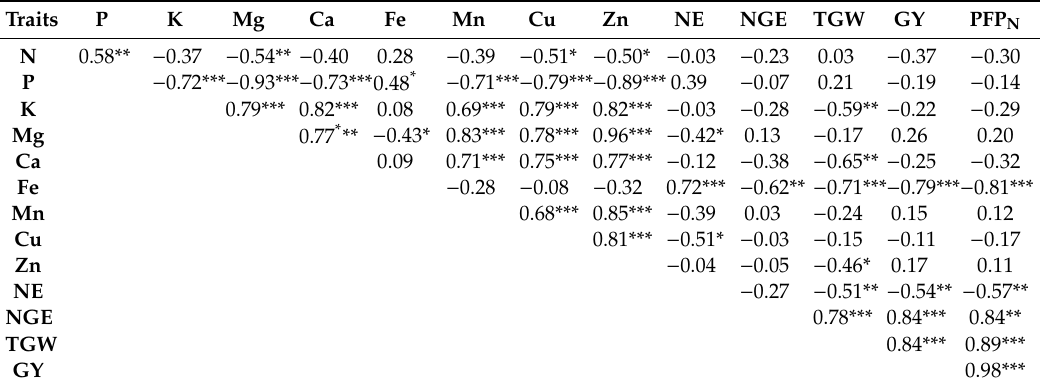
Table 6. Correlation matrix between contents of nutrients in grain of spelt wheat, n = 24.